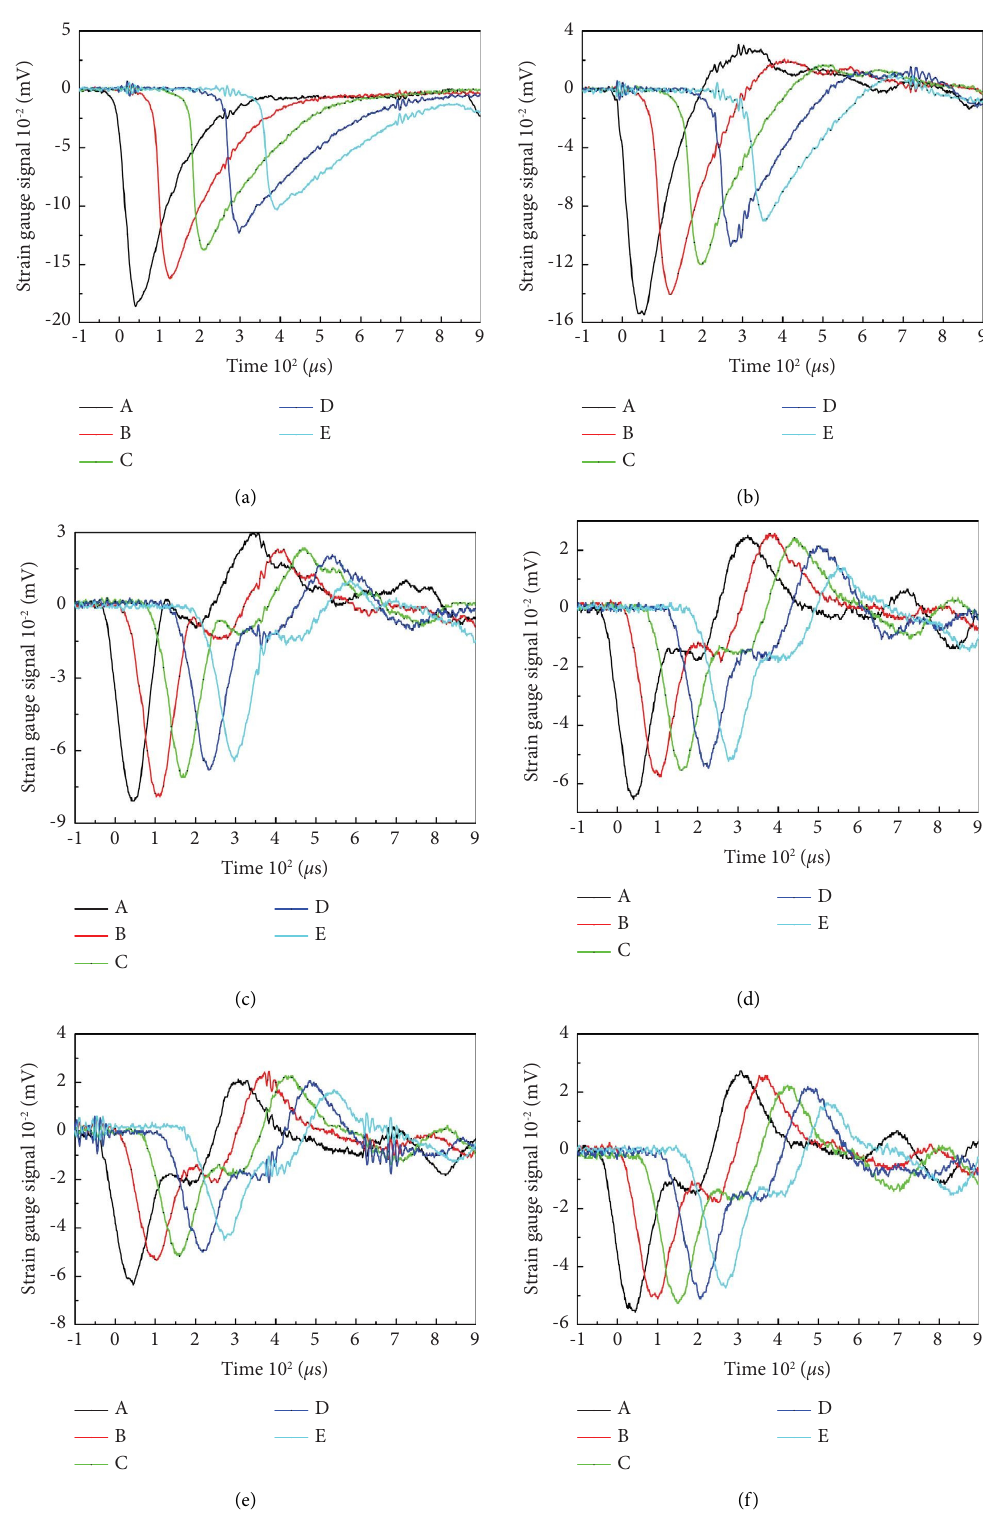
Figure 4: Stress waves under diferent loading stresses [14]. (a) 0MPa. (b) 2.76MPa. (c) 11.04MPa. (d) 19.32MPa. (e) 27.60MPa. (f)